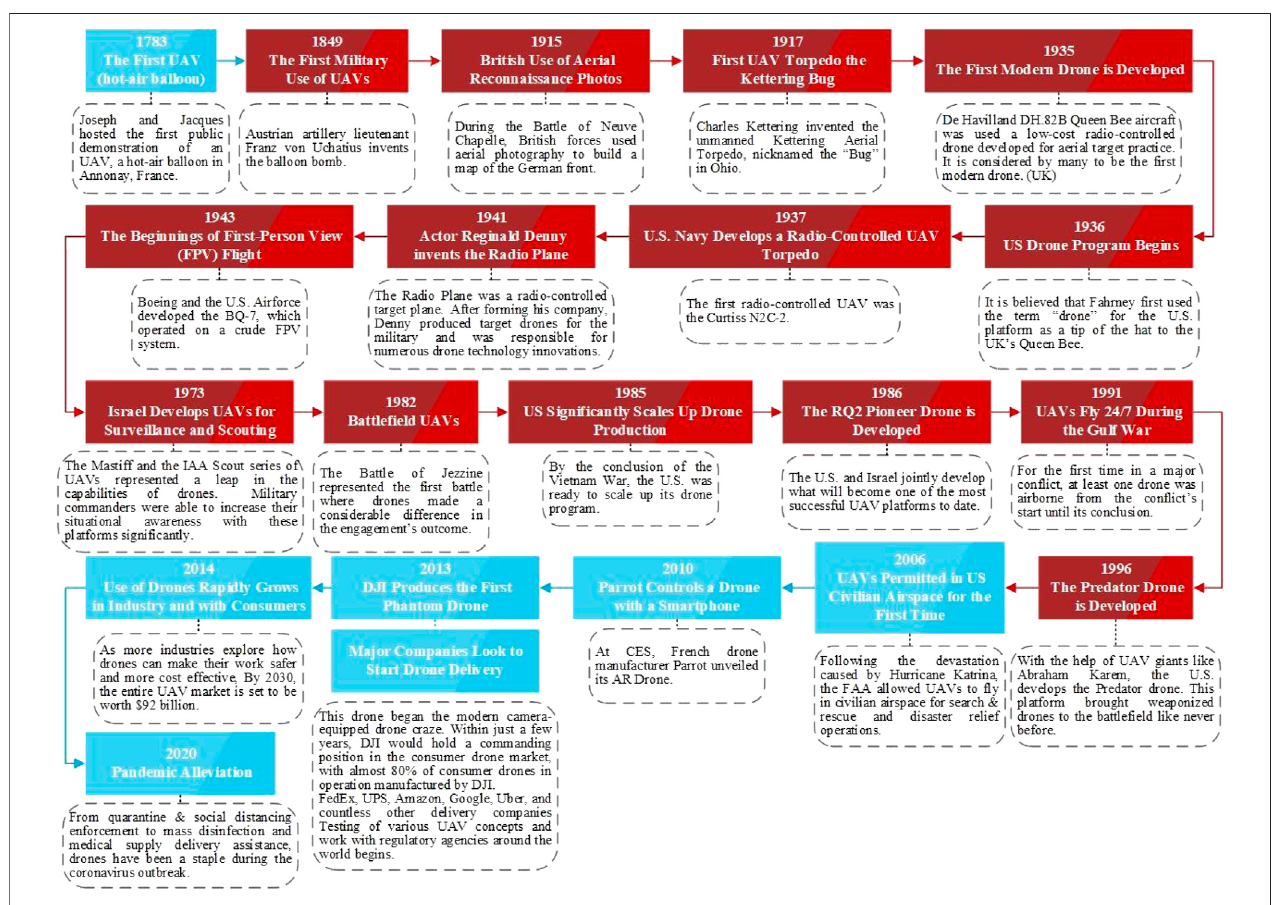
FIGURE 1 | History of UAV development.